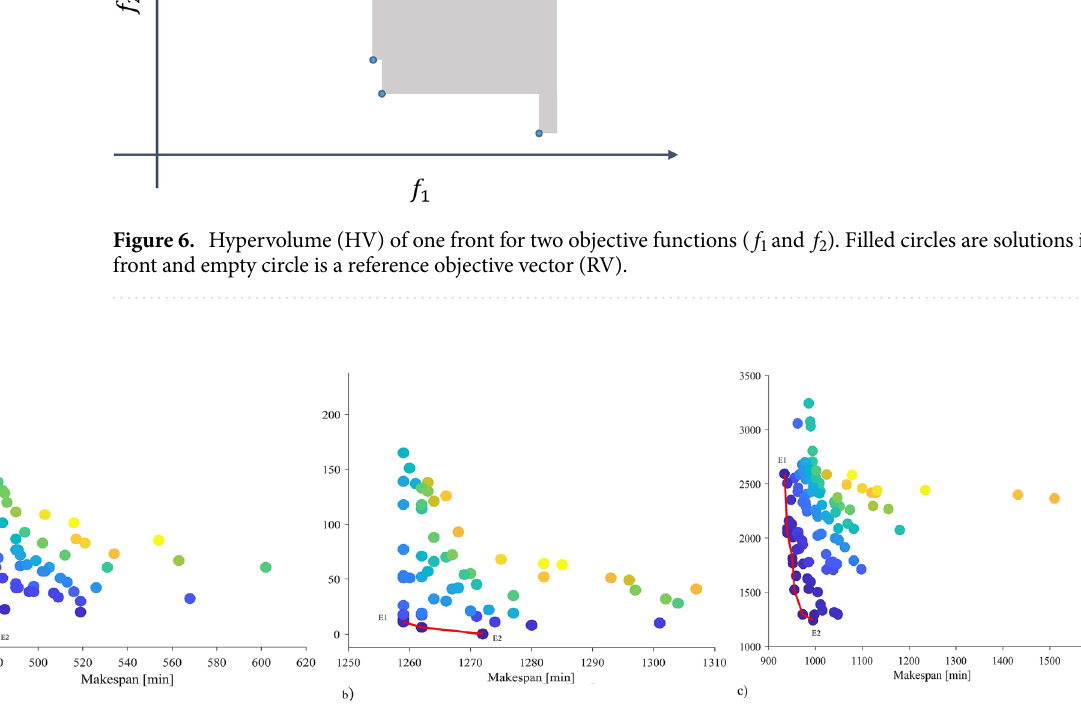
Figure 7. Candidate solutions represented by their quality indicators (circles) obtained by five optimization algorithms and true Pareto front (line) for problem ( a ) BK15, ( b ) BK40 and ( c ) BK50. The color gradient of the circles represents the quality of the solutions, with the darkest blue being the best and pale yellow being the